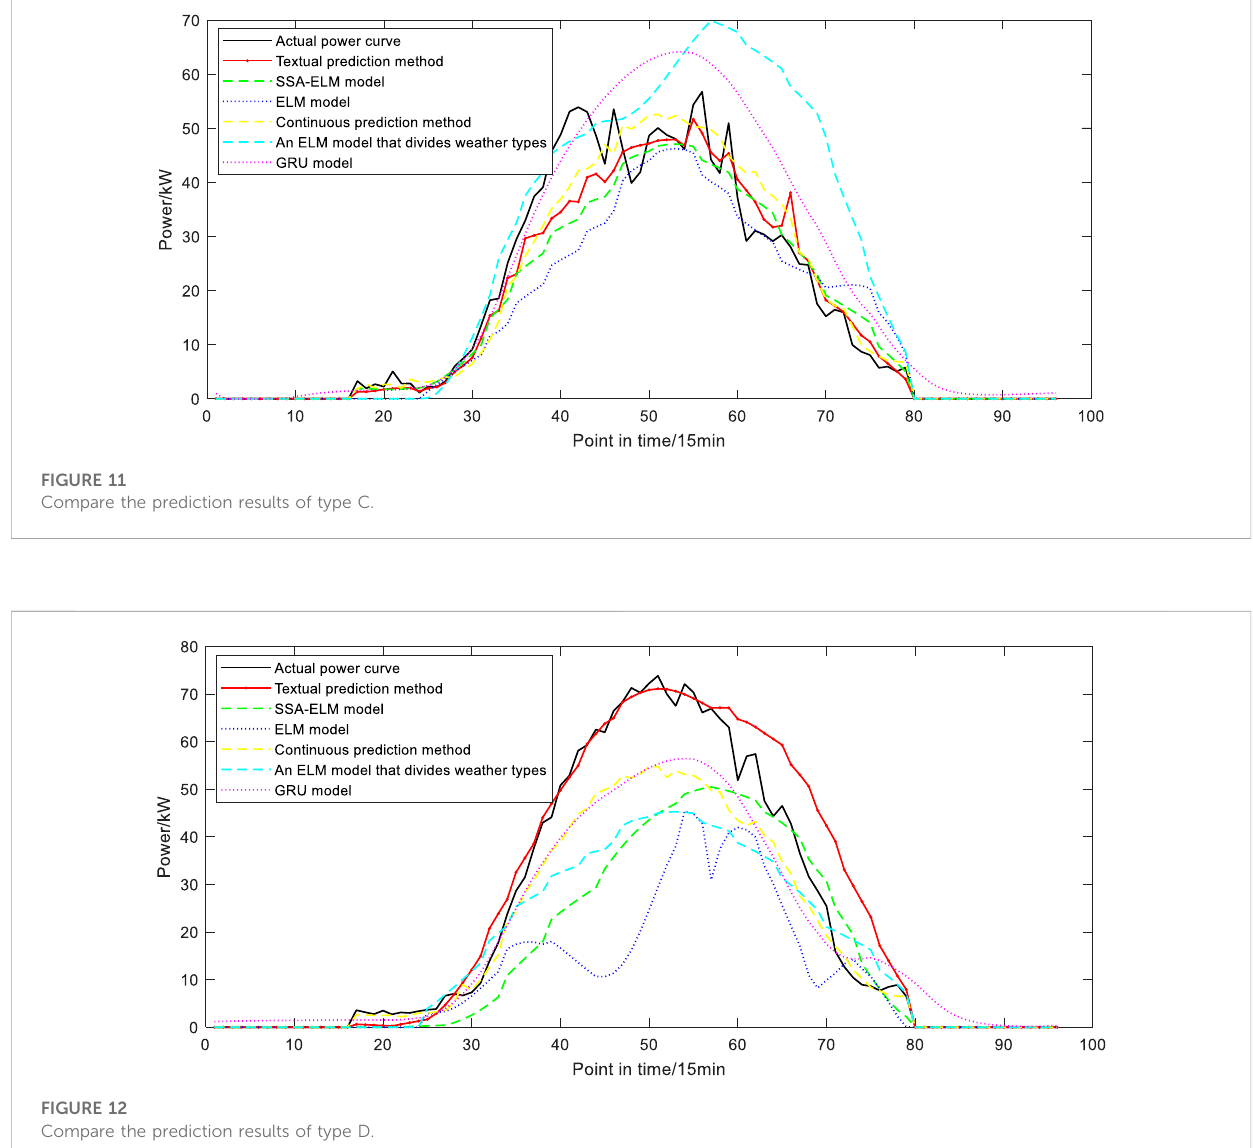
FIGURE 12 Compare the prediction results of type D.